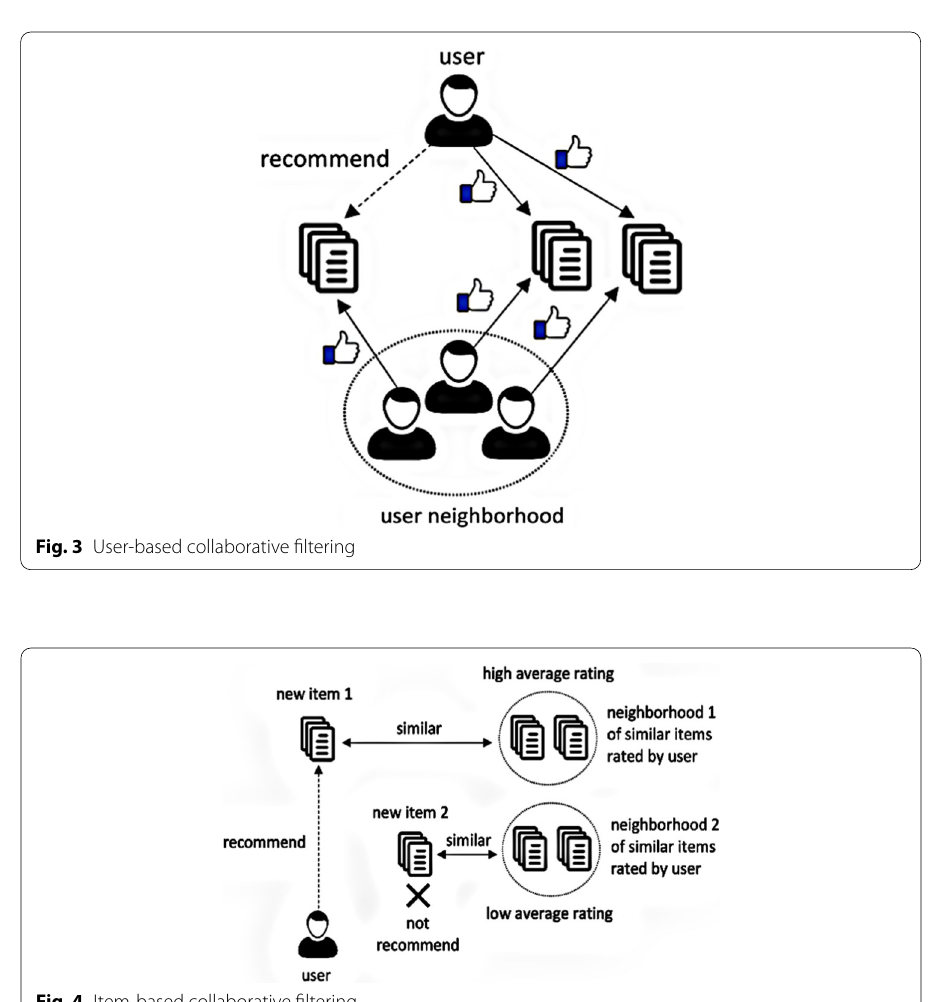
Fig. 4 Item-based collaborative